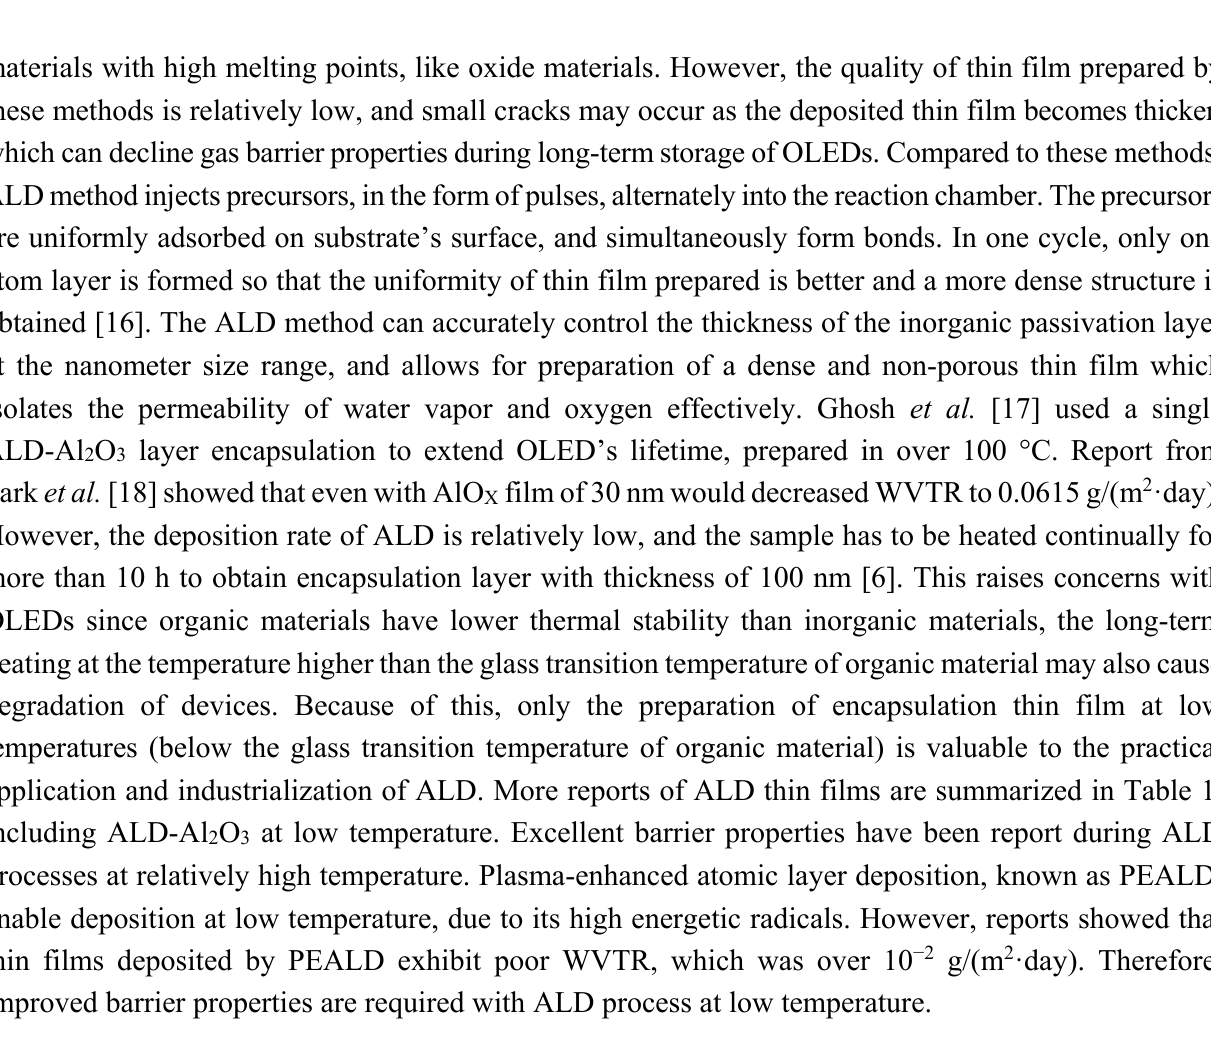
Table 1. Summary of the barrier properties of thin films including material, deposition condition and barrier